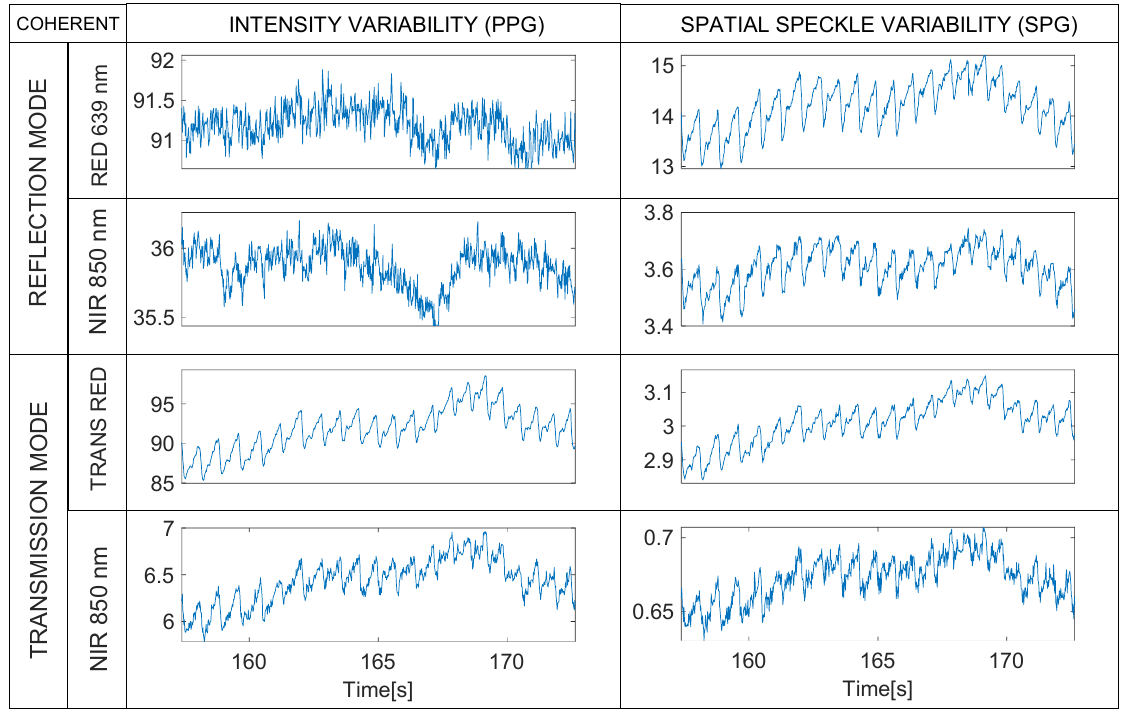
Figure 11. Coherent mode. Synchronous rPPG ( left ) and rSPG ( right ) signals extracted from the 4 multiplexed Laser light sources (1200 µ s integration time). Note the differences in waveform morphology in reflective mode, versus the similarities in transmissive mode. Note that raw waveforms are displayed without vertical inversion—PPG and SPG synchronous signals from a random subject with 1200 µ s integration time.